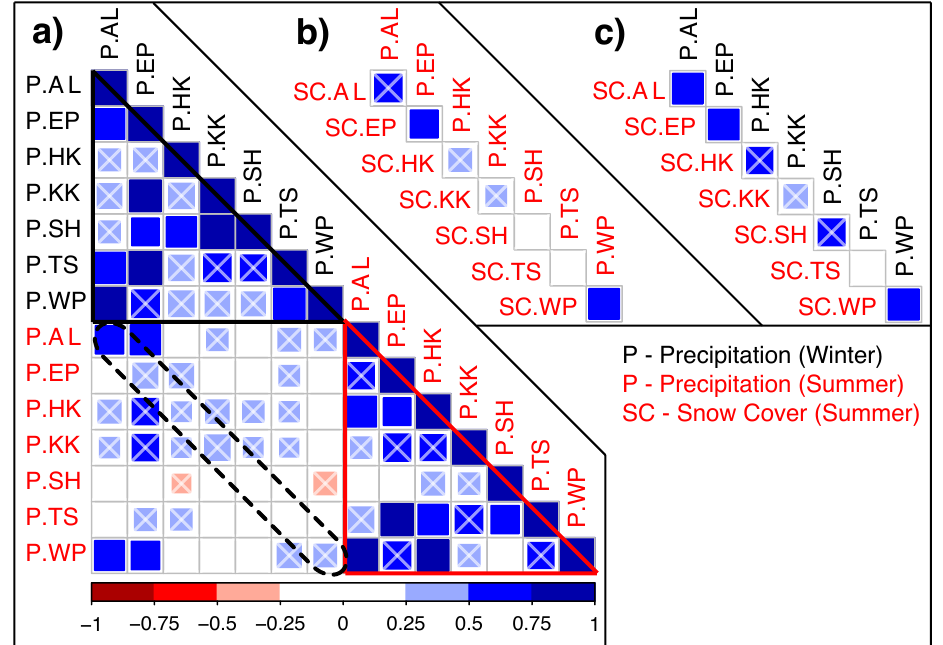
Figure 10. Spatiotemporal correlation of ( a ) HANTS summer and winter precipitation anomalies; ( b ) HANTS summer precipitation anomalies with snow cover anomalies; and ( c ) HANTS winter precipitation anomalies and summer snow cover anomalies. Color coding corresponds to the correlation coefficient multiplied by either one (positive) or − 1 (negative correlation). Crosses mark non-significant correlations ( p -value ≥